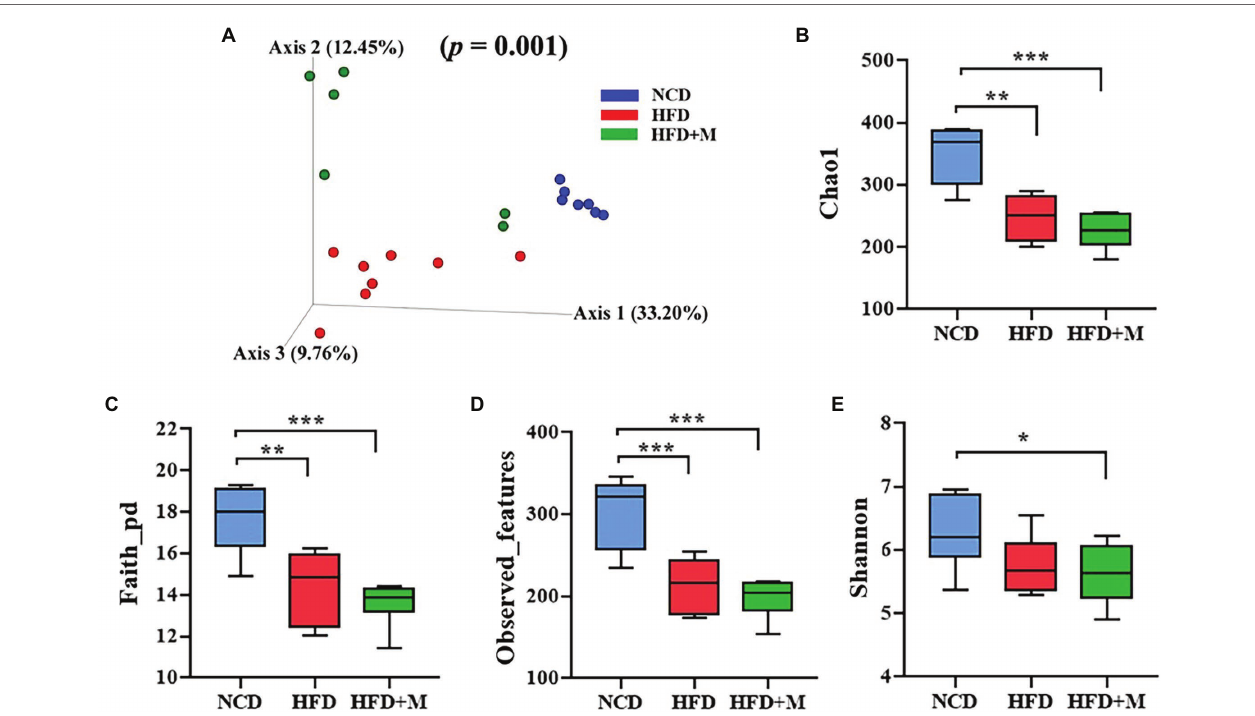
FIGURE 7 | The beta diversity, structure, and richness of the gut microbiota in three groups of rats. (A) Nonmetric multidimensional scaling (NMDS) score plot based on principal component analysis (PCA) score plot based on microbiota composition. (B–E) The gut microbiota diversity as calculated using Shannon’s index (B) , Chao1 (C) , Faith-pd (D) , and observed-features (E) index of each rat group: NCD, Normal Chow Diet (control) rats; HFD, HFD rats; HFD + M, HFD rats received fecal microbiota transplant from HFD-T monkeys. Values are presented as mean ± SE. ( n = 7). *, p < 0.05; **, p < 0.01; ***, p < 0.001, compared with NCD